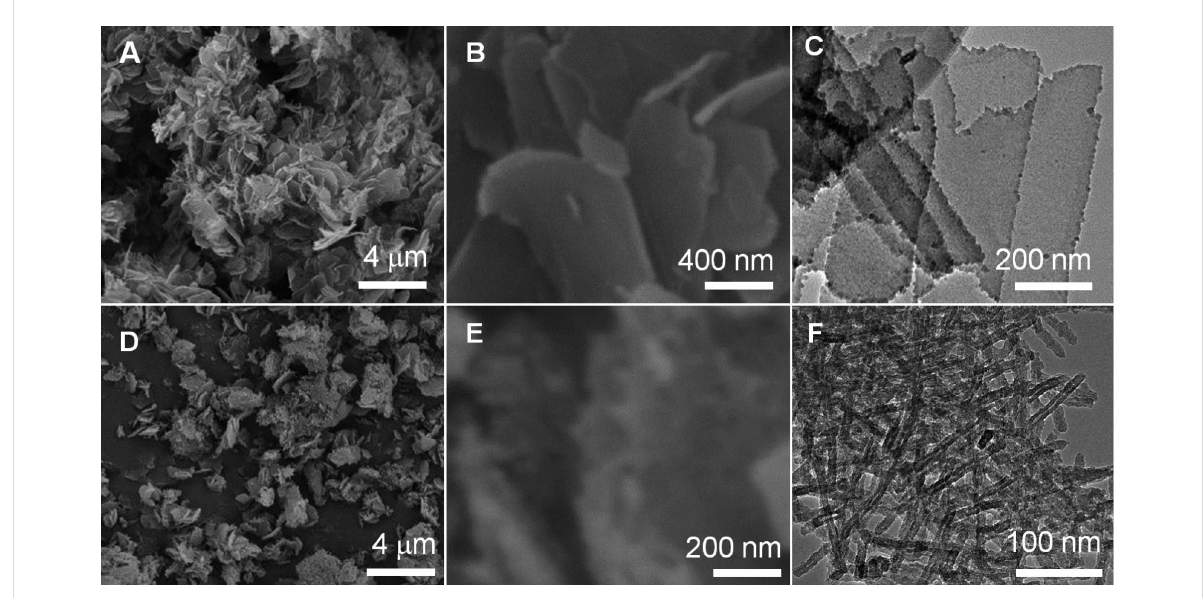
Figure 4: SEM (A, B, D and E) and TEM (C and F) images of silica prepared with molar ratios [OH]/[EI] of 0.56 (A–C) and 3.2 (D–F). The LPEI aggre- gates were formed first by dropping aqueous NaOH solution into a mixture of 0.5 g of PEI-HCl and 6 mL of water and then washing aggregates with water to pH 7.0. The silicification conditions are the same as described in Figure 1.